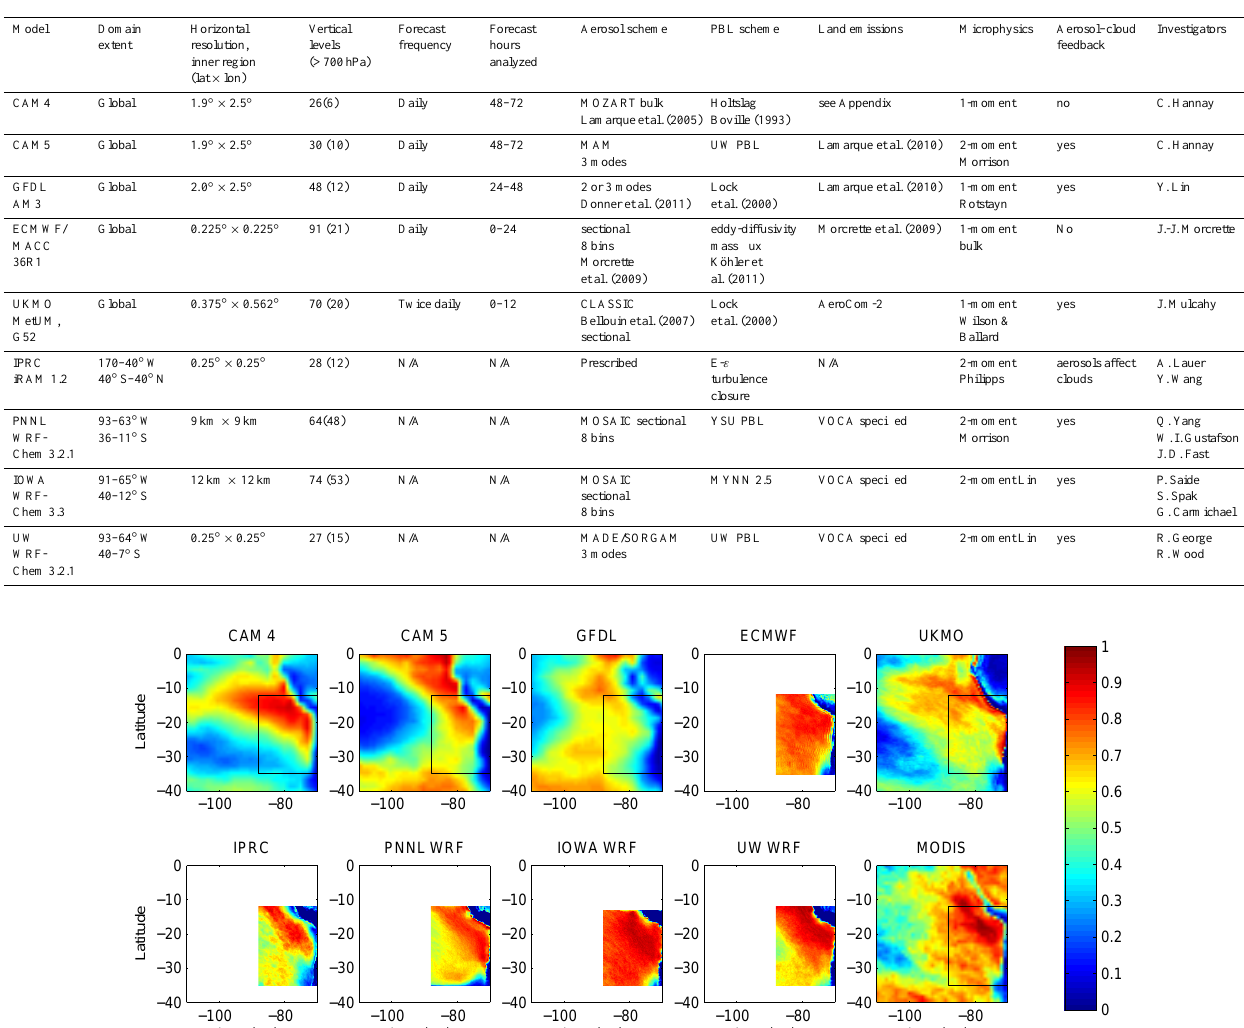
Table 1. Model parameters and physics.